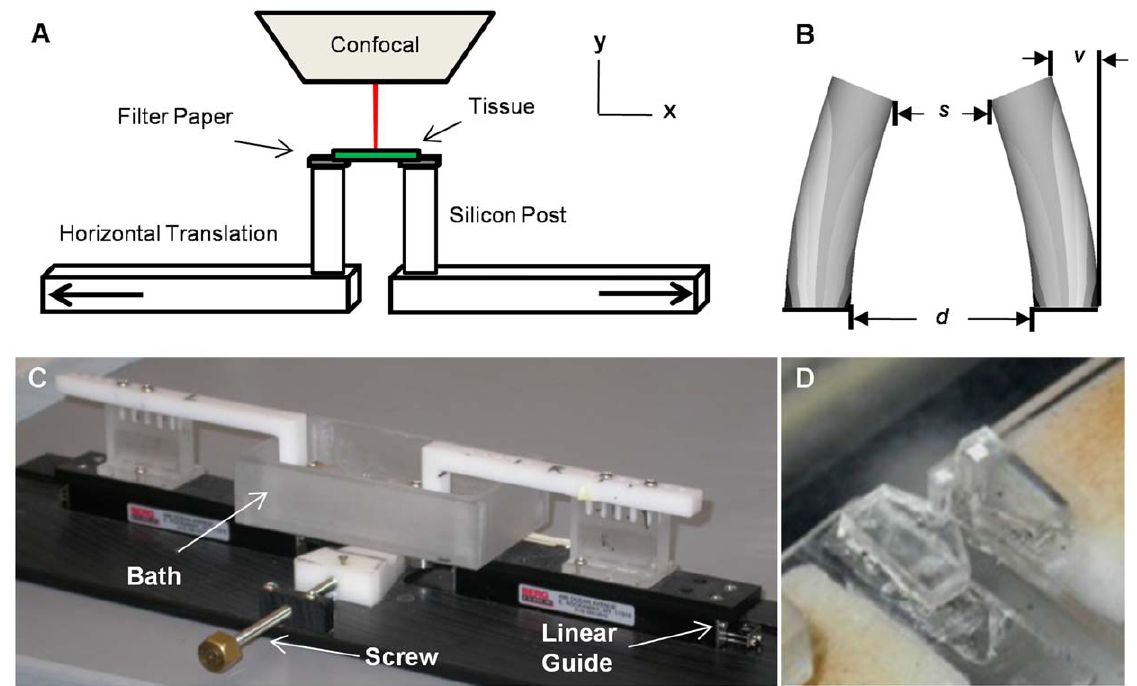
Figure 1. Meso-scale uniaxial tensile device. (A) Experimental stage controls the opposite co-linear translation of two cylindrical elastomeric beams. Tissue is mounted on the top surface of the posts using filter paper. The assembly is fully submerged in a buffered saline bath, and able to be imaged continuously under an upright confocal system. (B) Silicon post defection (v), post separation (s), and horizontal translation (d) were used for the biomechanical analysis. (C) Fabricated device implements a screw-driven wedge design for separation of the two linear rail guides at micro-meter resolution. (D) Detailed view of the silicon-post setup located inside the water bath. Distance between the posts is approximately 500 um.